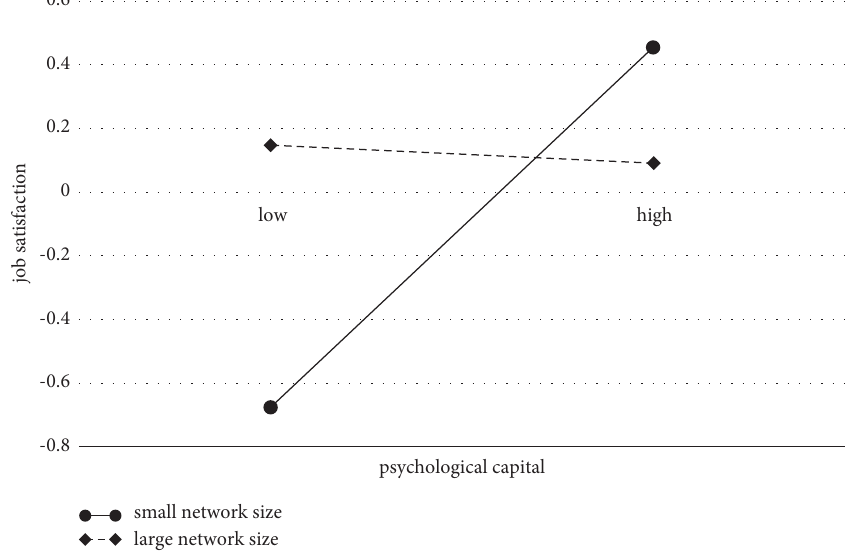
Figure 3: Interaction of psychological capital and network size on job satisfaction. Table 8: Hierarchical regression of moderating effect of tie strength on the relationship between psychological capital and job satisfaction. Variables